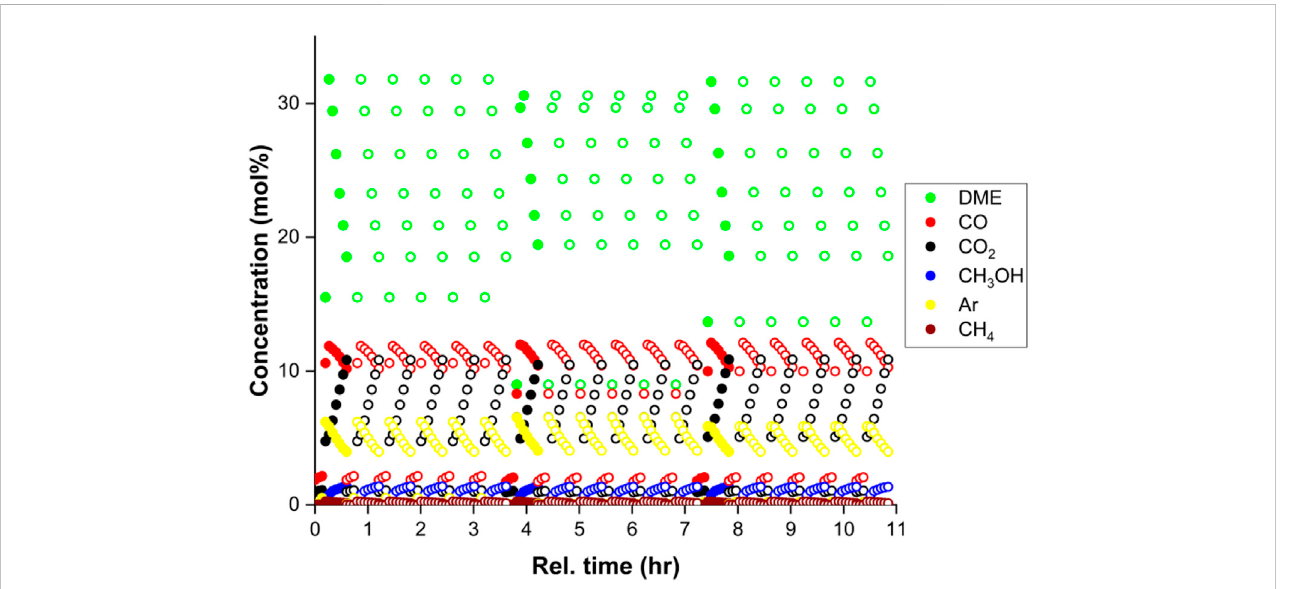
Experimental data at 250 ° C and 25 bar(a) for a CO 2 feed with stoichiometric hydrogen, with argon tracer (24.5% CO 2 , 73.6% H 2 , 1.9% Ar, GHSV 93 h -1 ), measured for reactor column 6 ( fi lled dots). For reactor columns 1 – 5 the data from column 6 is extrapolated (copied, open dots), for the purpose of interpreting the performance of the ensemble of columns.